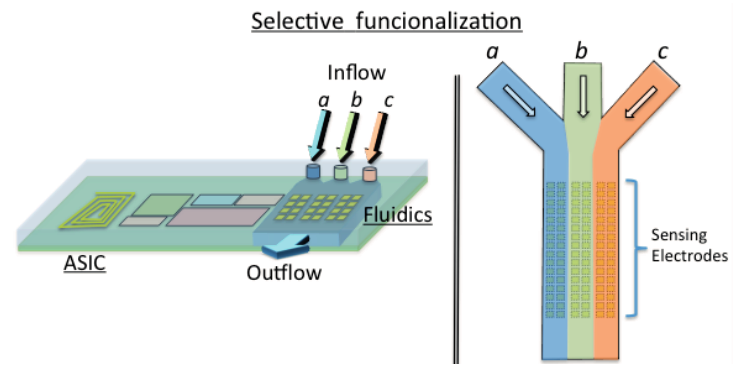
Figure 7. Microfluidic configurable array of biosensors on-chip.